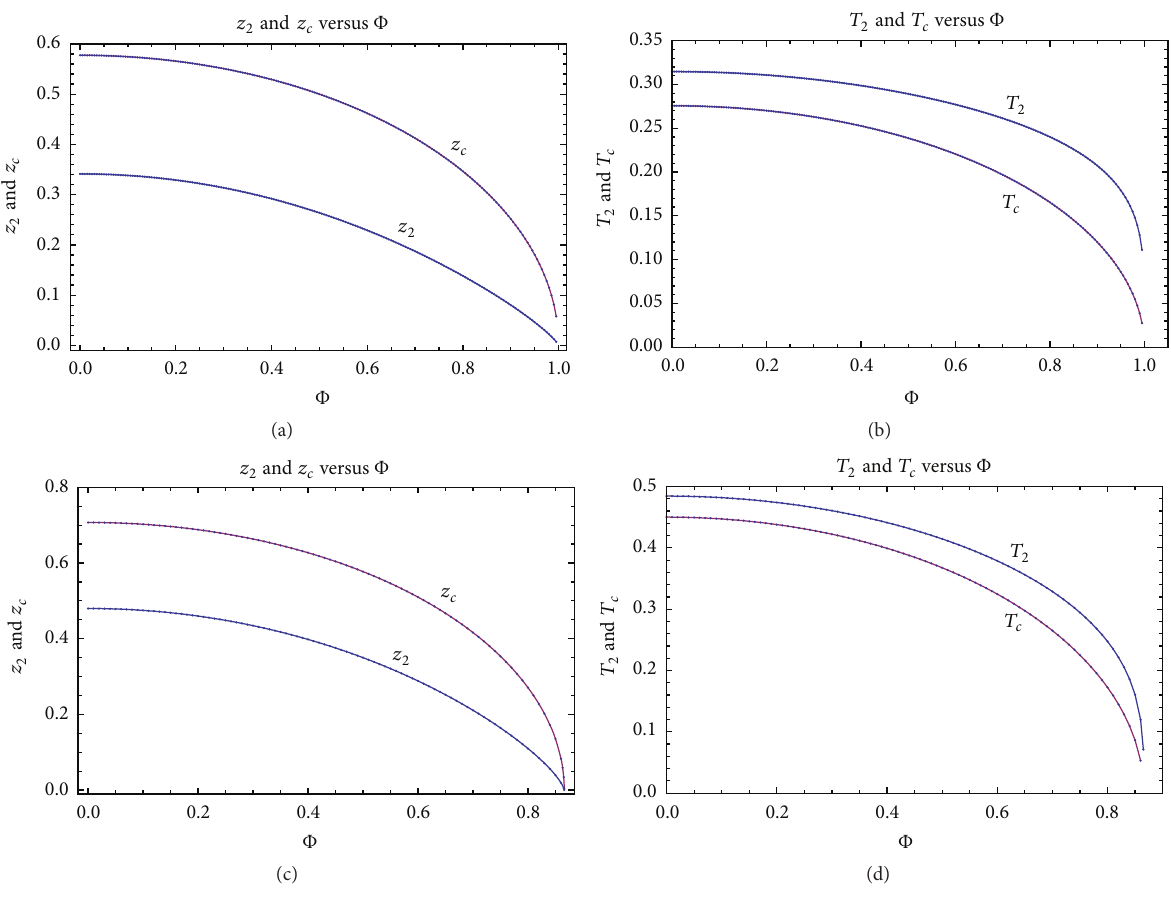
Figure 5: The heat capacity condition 𝑆 󸀠󸀠 (𝐸 𝑟 ) < 0 is characterized by the sizes 𝑧 2 and 𝑧 𝑐 . Allowed region is the area between 𝑧 2 and 𝑧 𝑐 . In (a) and (b): the saturation size 𝑧 2 , the critical size 𝑧 𝑐 , and the corresponding temperatures versus the bulk potential Φ for AdS 4 . In (c) and (d): the saturation size 𝑧 2 and the critical size 𝑧 𝑐 and the corresponding temperatures versus the bulk potential Φ for AdS 5 . For all plots, we set = 𝑔 = 2 𝑔 𝑏 𝑓